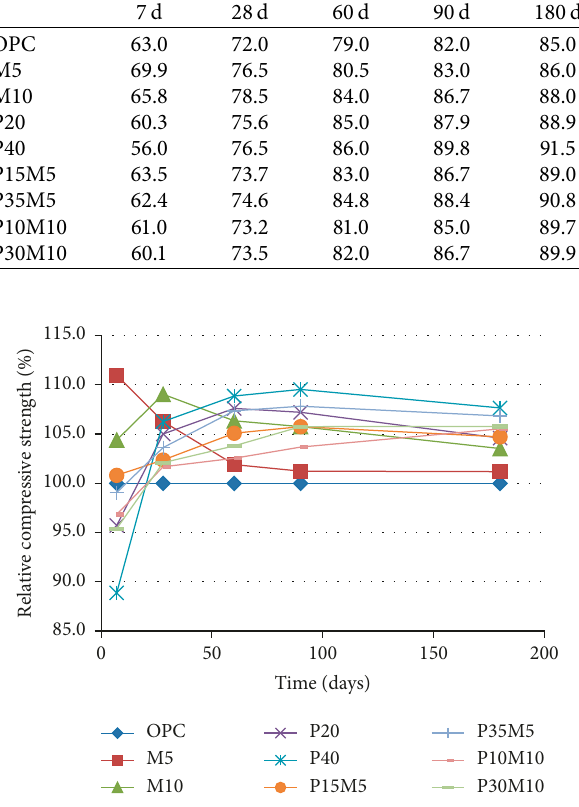
Figure 10: Relative compressive strength of concrete.